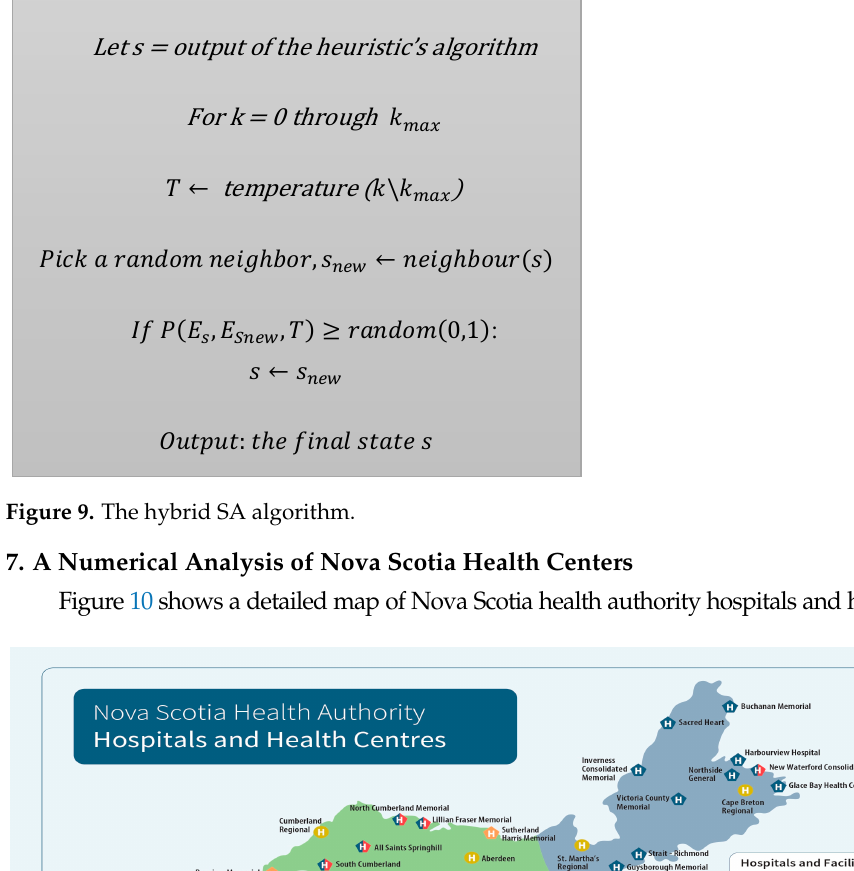
11 of 21 Figure 8. Time-comparison diagram of the SA and heuristic algorithms for different test problems (15 ORs).